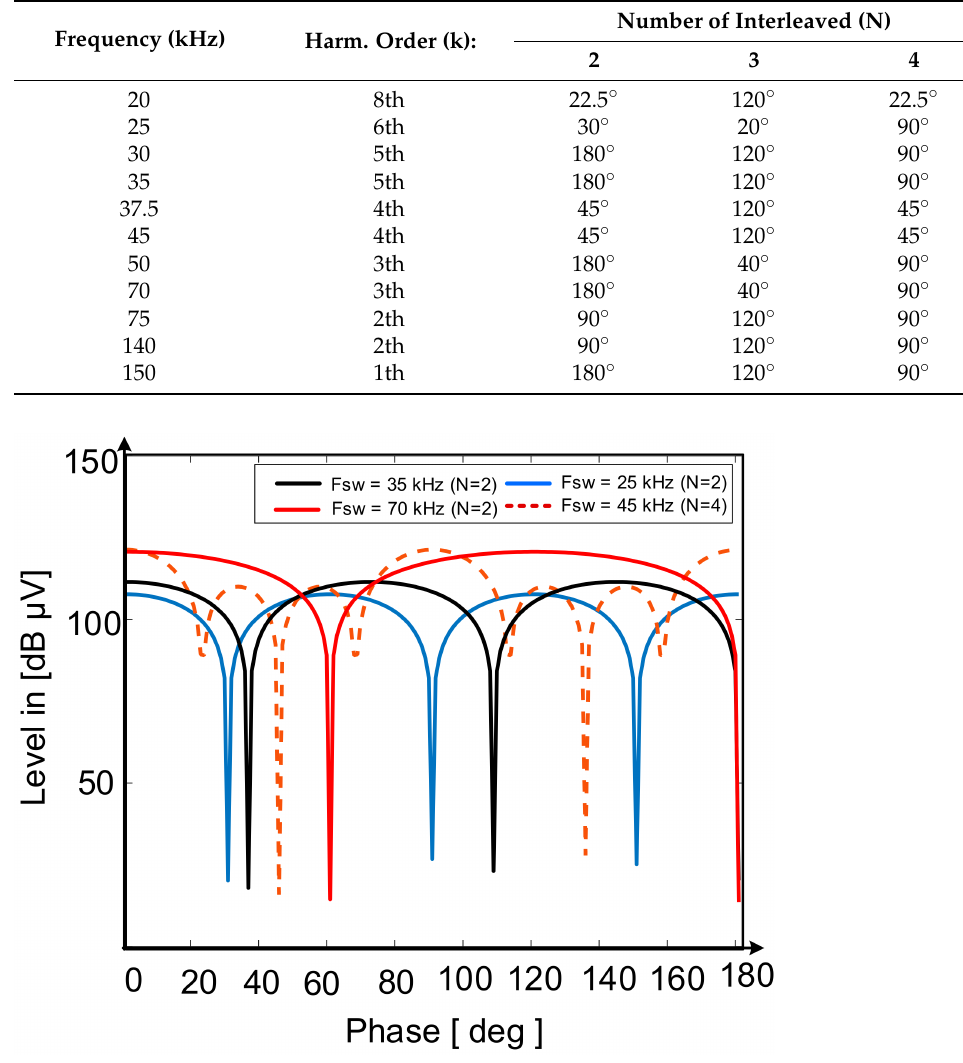
Table 3. The Unconventional Phase Shift Angles at the Switching Frequency Range (20–150 kHz) up to Four Units Interleaved for Band B.